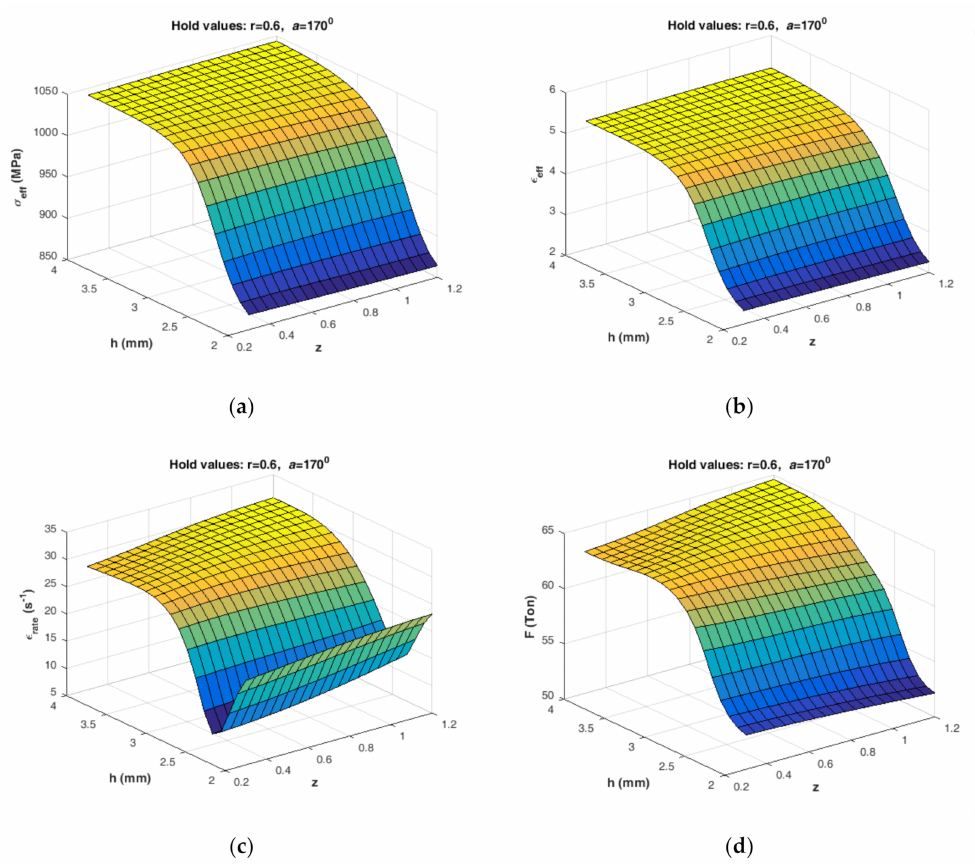
Figure 13. Interaction e ff ect of billet size ratio and land height on forming behavior: ( a ) e ff ective stress; ( b ) e ff ective strain; ( c ) e ff ective strain rate; and ( d ) punch